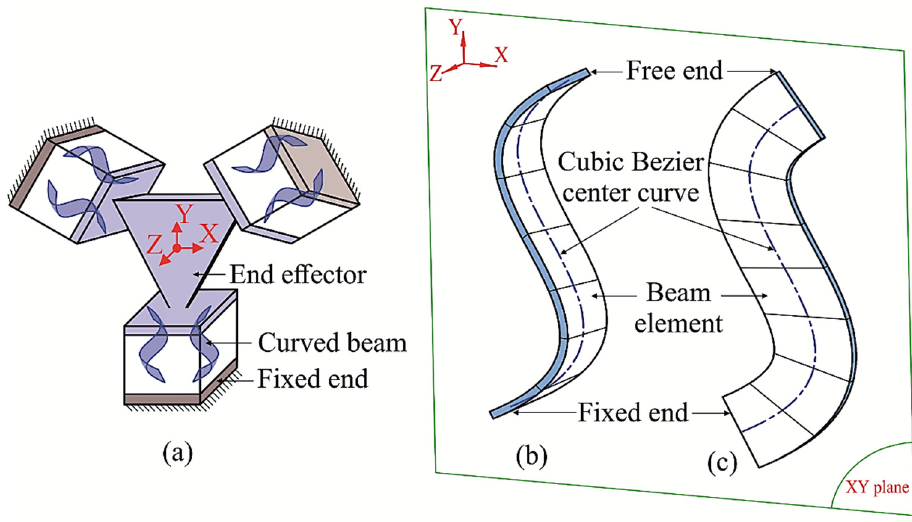
Figure 1. General model of 3-legged compliant parallel mechanism (CPM) synthesized by beam- based method: ( a ) overall structure of the CPM; ( b , c ) structures of the 90°-oriented and 0°-oriented curved beams, respectively.